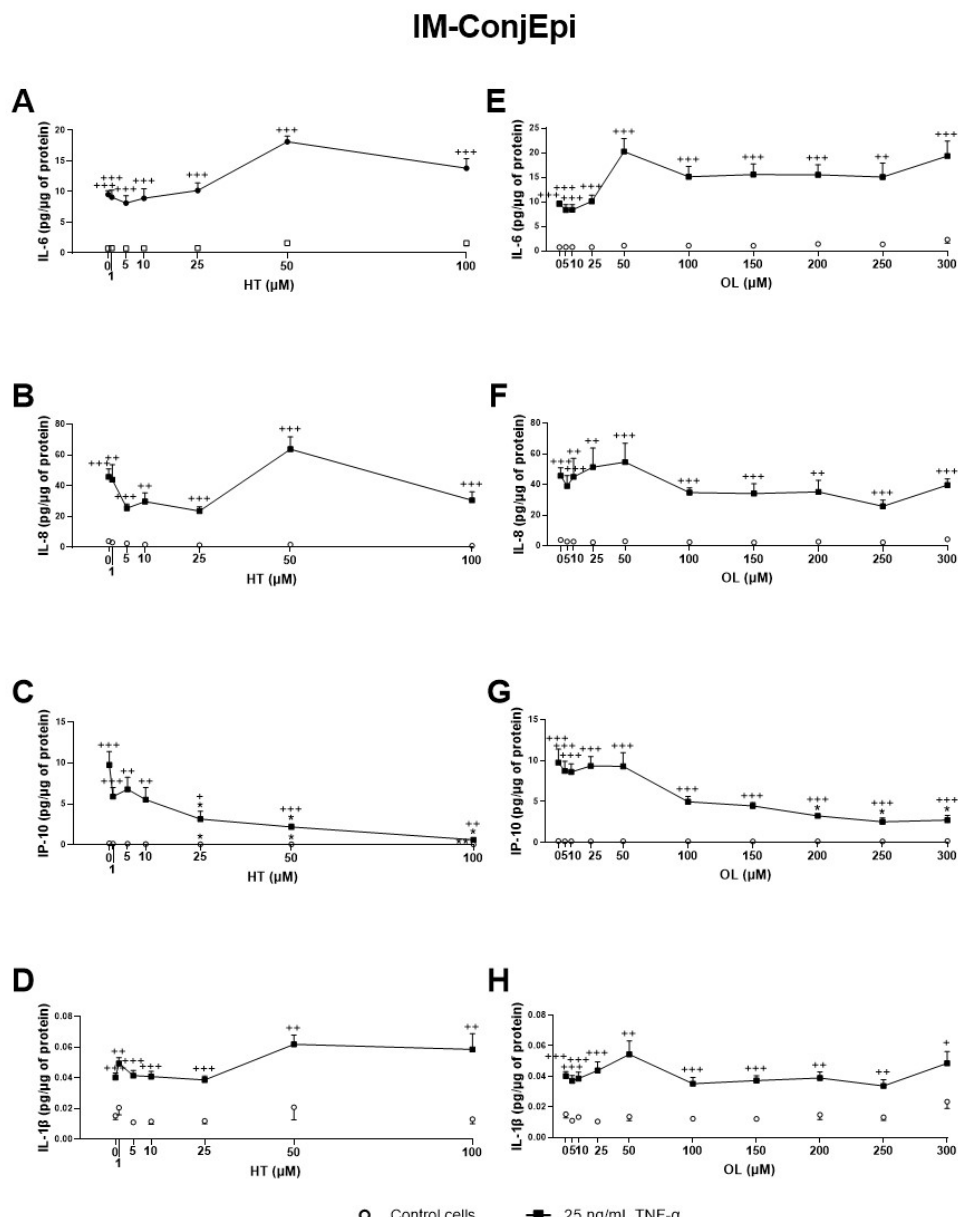
Figure 6. Effect of Hydroxytyrosol (HT) and Oleuropein (OL) on TNF- α -induced cytokine release by IM-ConjEpi cells. Cells were pre-treated with HT (1, 5, 10, 25, 50, and 100 µ M), OL (5, 10, 25, 50, 100, 150, 200, 250, and 300 µ M), or vehicle (cell culture medium) for 2 h. Following this, they were stimulated with 25 ng/mL TNF- α in the presence of the treatments for 24 h (black squares). Vehicle-treated-TNF- α stimulated cells and cells not stimulated with TNF- α (white circles) were used as control. IL-6, IL-8, IP-10, and IL-1 β were measured in cell supernatants by a multiplex bead-based array. HT and OL reduced IP-10 levels at 25 µ M ( C ) and 200 µ M ( G ), respectively. No significant inhibition was observed for IL-6, IL-8, and IL-1 β , neither by HT ( A , B , D , respectively) nor by OL ( E , F , H , respectively). Data are presented as picograms (pg) of cytokine/chemokine per micrograms ( µ g) of total protein for three independent experiments (performed in duplicate) ± SEM. * p < 0.05, compared with vehicle-treated-TNF- α stimulated cells; + p < 0.05, ++ p < 0.01, +++ p < 0.001, compared with control cells.